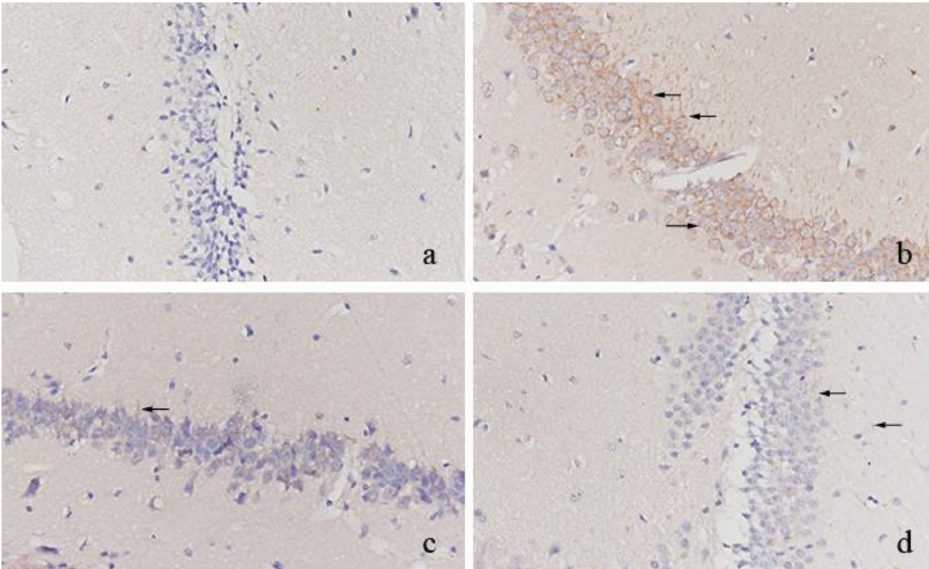
Figure 2. Observation of neurons in brain tissue of mice in normal group ( a ), model group ( b ), positive group ( c ), and peppermint essential oil group ( d ). The arrow points to A β precipitation. (HE staining, × 200).